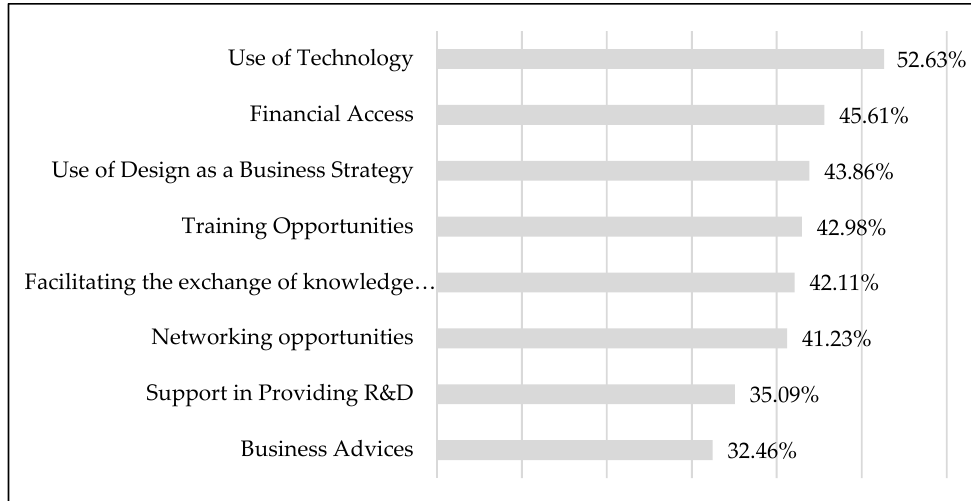
Figure 5. Critical entrepreneurial skills for CCIs success. Ranking results. Source: Authors elaboration on data collected and shown in TRACES D3.1 deliverable.